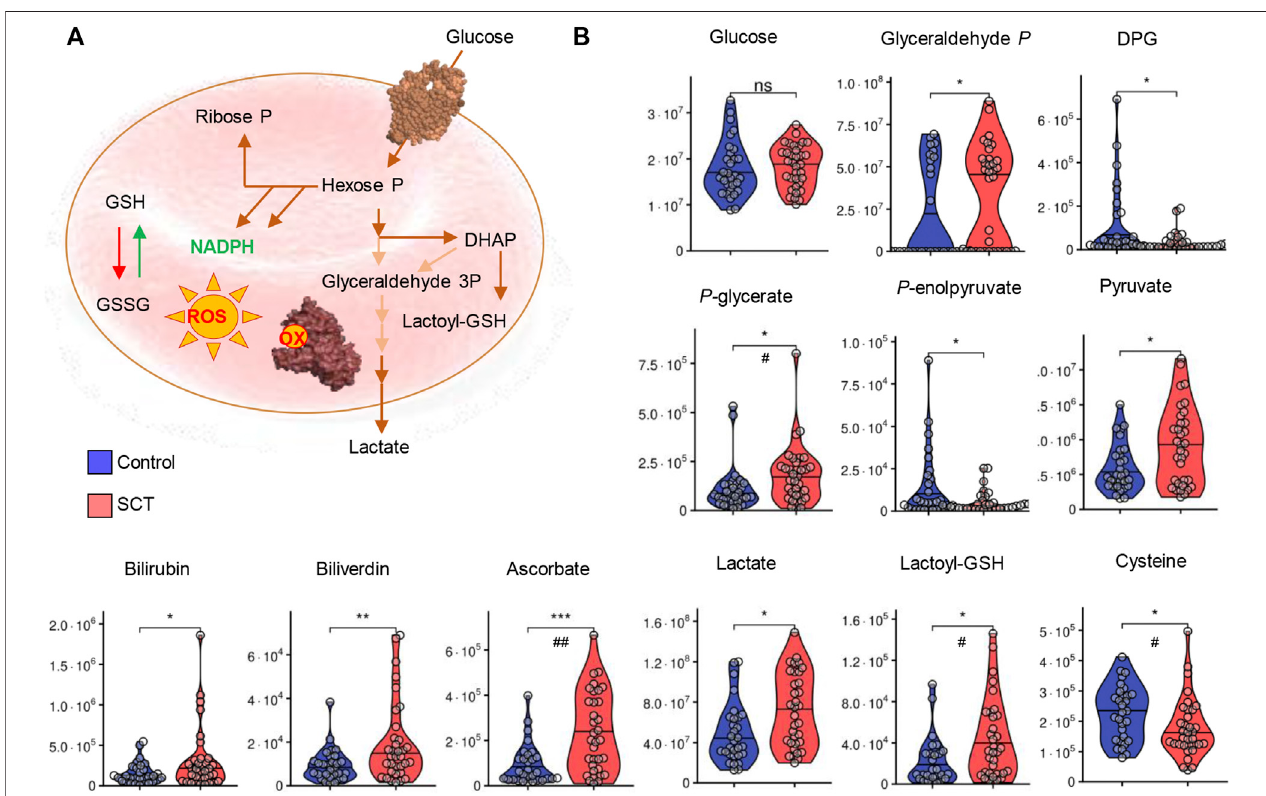
FIGURE4| Overview ofglycolysis,heme metabolismand redox metabolismin plasma from control (blue) and sickle cell trait (red) subjects. < /b > Asterisks indicate signi fi cance(* p < 0.05;** p < 0.01;*** p < 0.001Wilcoxon/Mann-Whitney U -test).FDR-corrected p -valuesareprovidedforallanalytesin SupplementaryTableS1 and indicated with # using the same signi fi cance ranges as per the asterisks in p -values above.